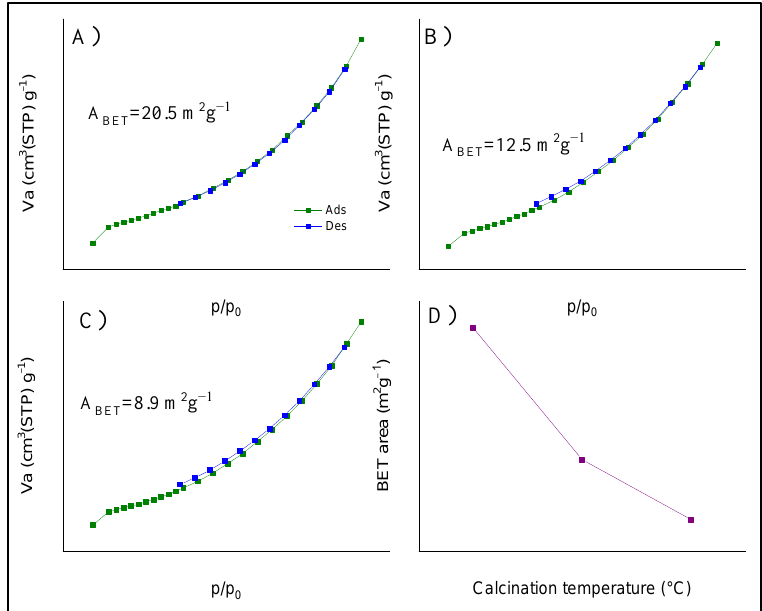
Figure 4. N 2 adsorption – desorption isotherms of LNO-600 ( A ), LNO-700 ( B ) and LNO-800 ( C ). BET area values vs. temperature of calcination are presented in ( D ).